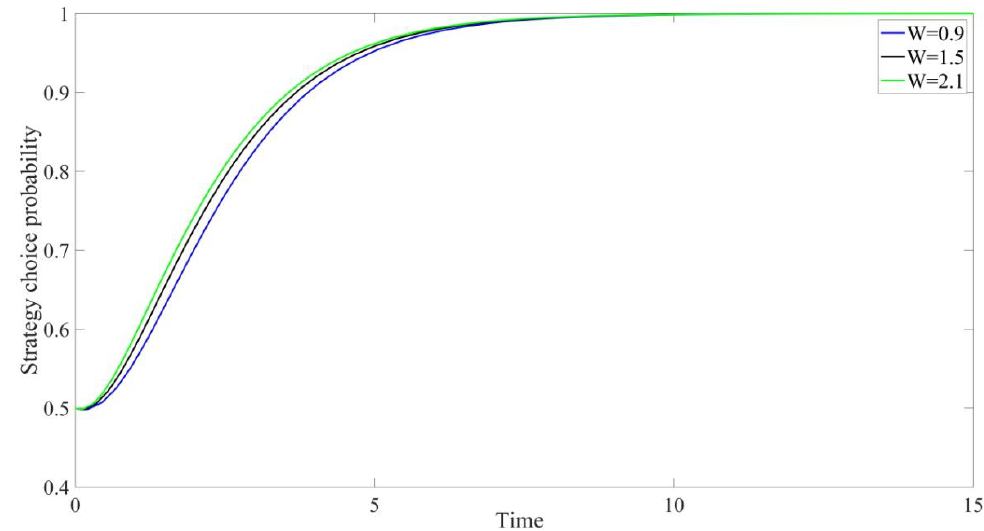
Figure 14. Simulation of different intensities of improving the payment system.